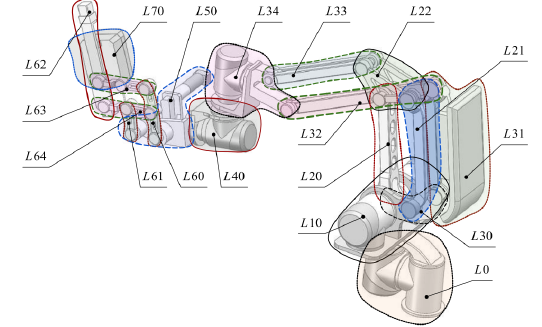
Figure 10. The link combinations in